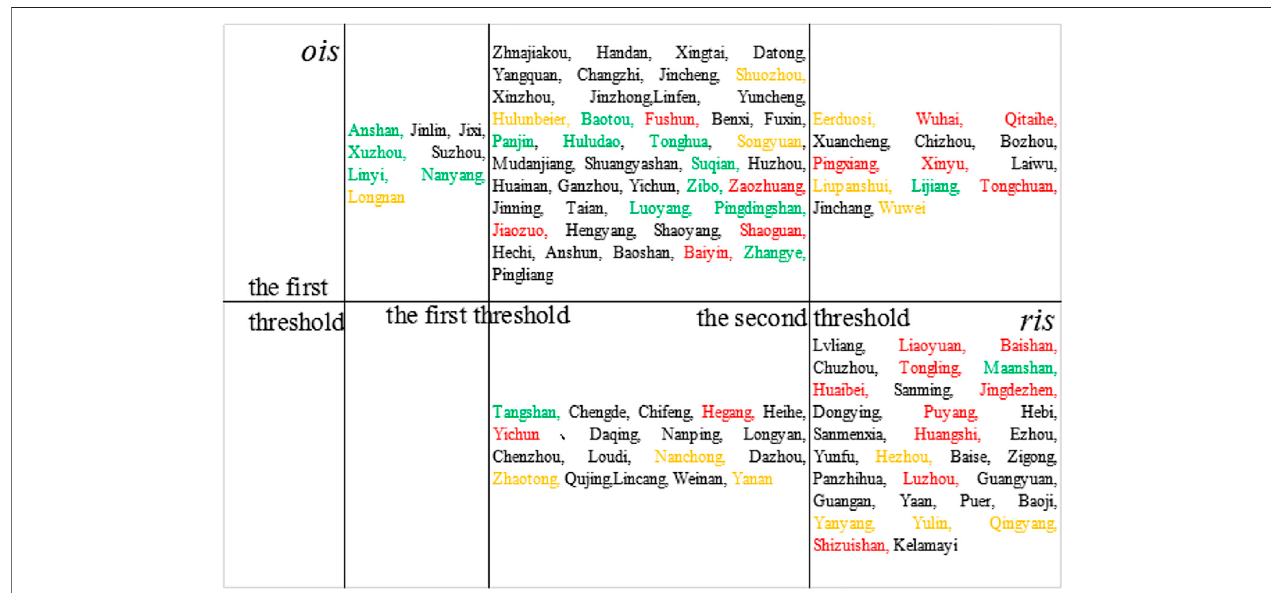
FIGURE 3 | Distribution of whether resource-based cities have crossed the threshold value in